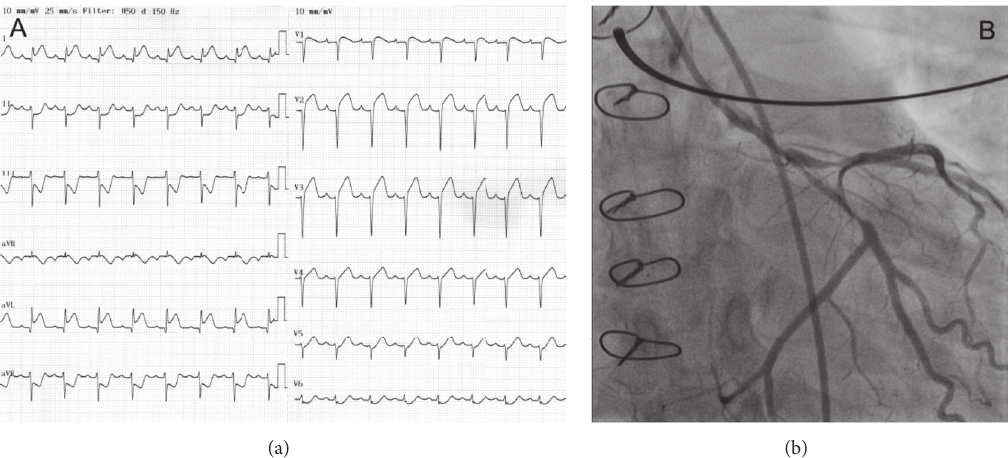
Figure 1: (a) Electrocardiogram at the time of admission showing global ischemia. (b) Acute coronary angiography showing severe coronary spasms in the left main, circumflex, and left anterior descending coronary artery.